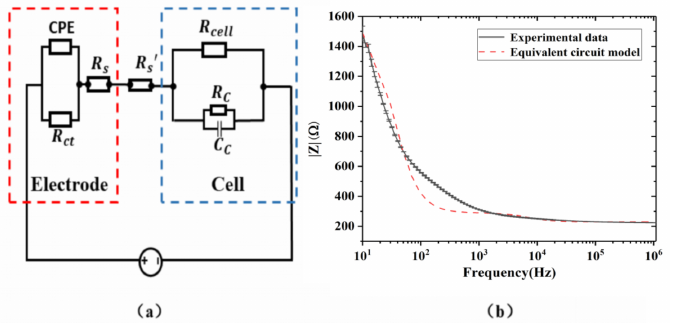
Figure 10. ( a ) Equivalent circuit model of the cell–electrode impedance test system. ( b ) Equivalent circuit fitting